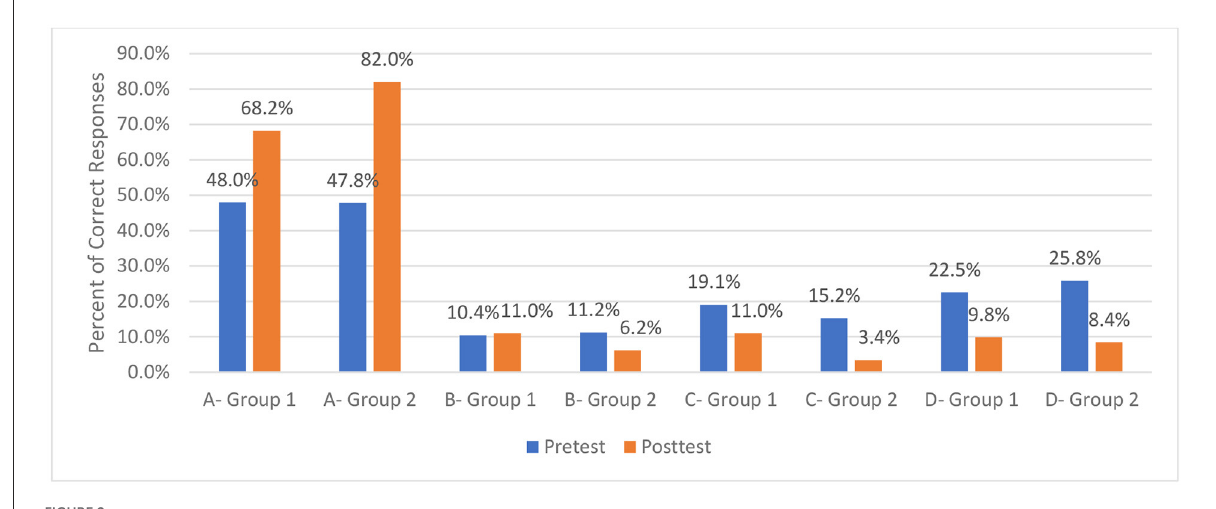
FIGURE2 Percent corrected by response category (Group 1 compared to Group 2). Response categories for two groups (Group 1 Response A, Group 2 Response A, Group 1 Response B, Group 2 Response B). Response A is the correct